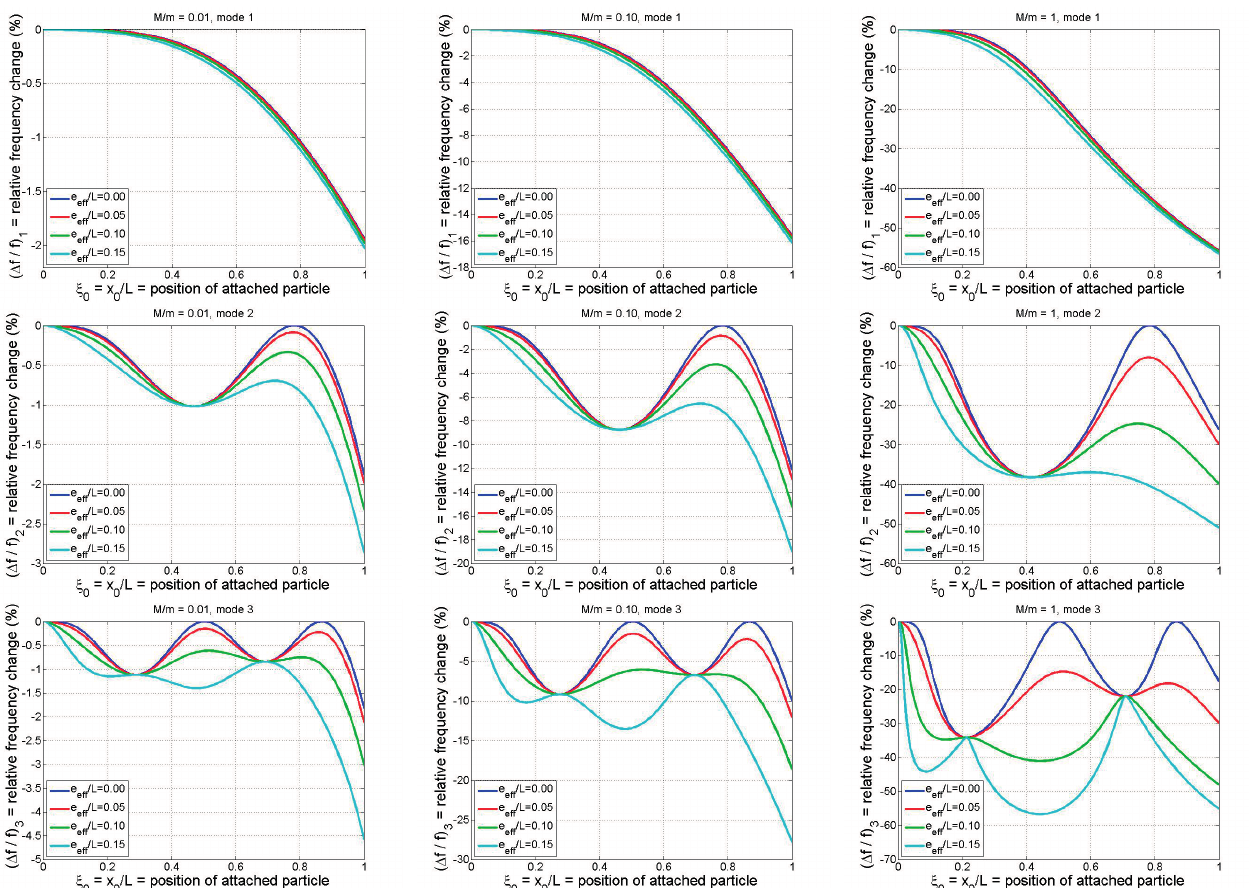
Figure 5. Relative frequency shifts (based on exact model) for the first three modes of a cantilever as functions of binding position of a particle of arbitrary shape. Results shown are for three different normalized particle masses and four different normalized effective eccentricities (Rows 1–3: modes 1–3; columns 1–3: M / m = 0.01, 0.1,